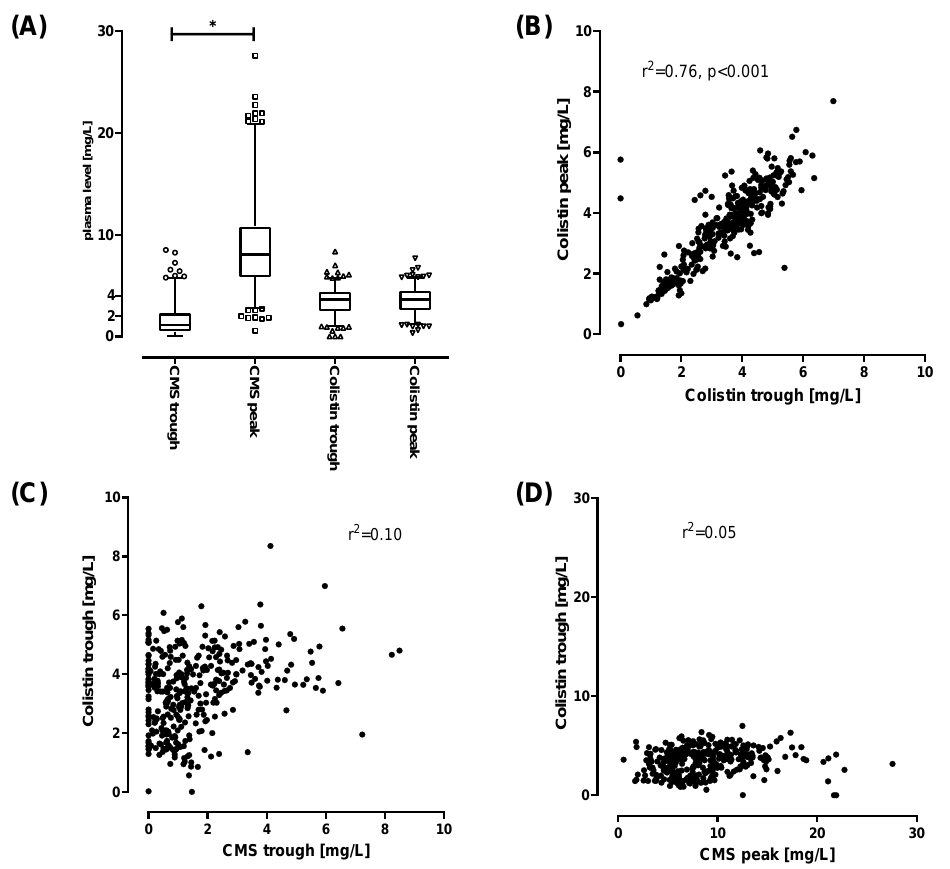
Figure 1. ( A ): range of observed Colistimethate sodium (CMS) and Colistin levels of samples taken 30 min after injection (CMS and Colistin peak levels) or immediately prior to injections of CMS (CMS and Colistin trough levels). A total of 779 samples were analyzed (CMS peak n = 385, CMS trough n = 388, Colistin peak n = 388, Colistin trough n = 394). Box indicates 25–75th percentile including median. Whiskers indicate 2.5–97.5 percentile. Outliers are plotted individually. * p > 0.001 for t -test comparing CMS trough vs CMS peak levels. ( B – D ): Linear correlation (Pearson) of Colistin peak and trough levels ( B ) CMS trough and Colistin trough levels ( C ) and CMS peak versus Colistin trough levels ( D